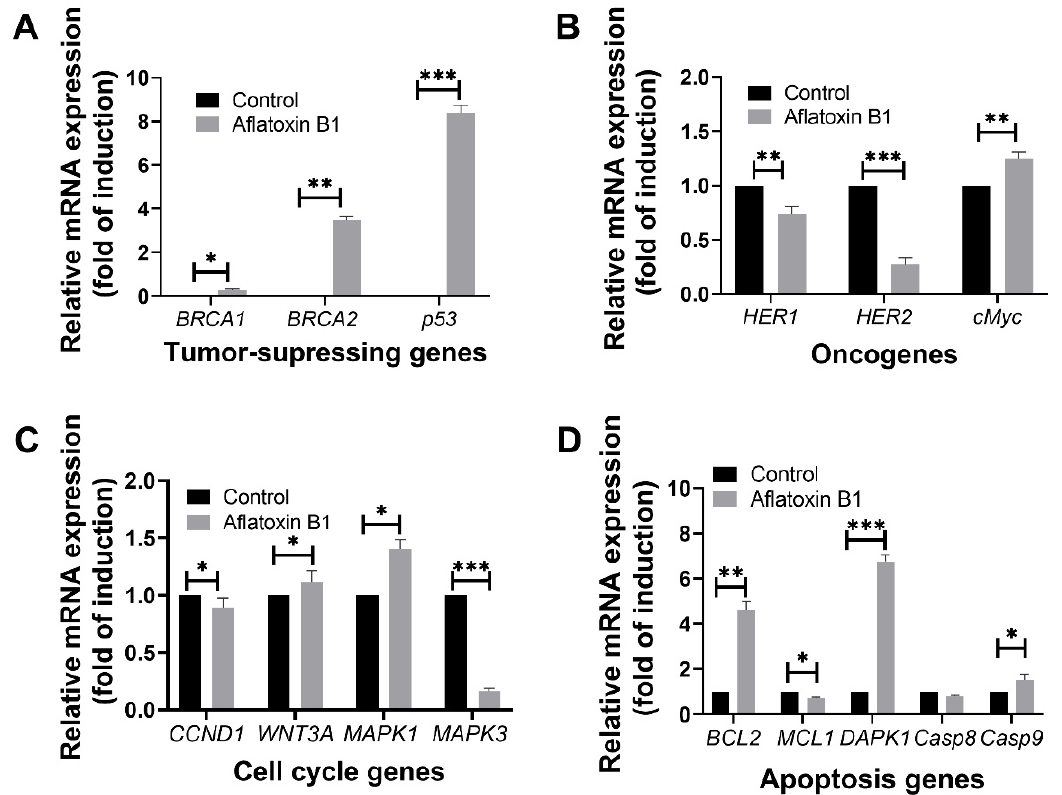
Figure 8. The effects of aflatoxin B1 on tumor-related gene expressions like tumor suppressing ( A ), onco- ( B ), cell cycle ( C ), and apoptosis ( D ) genes in MCF7 cells. * p < 0.05, ** p < 0.01 and *** p < 0.001 compared to control.